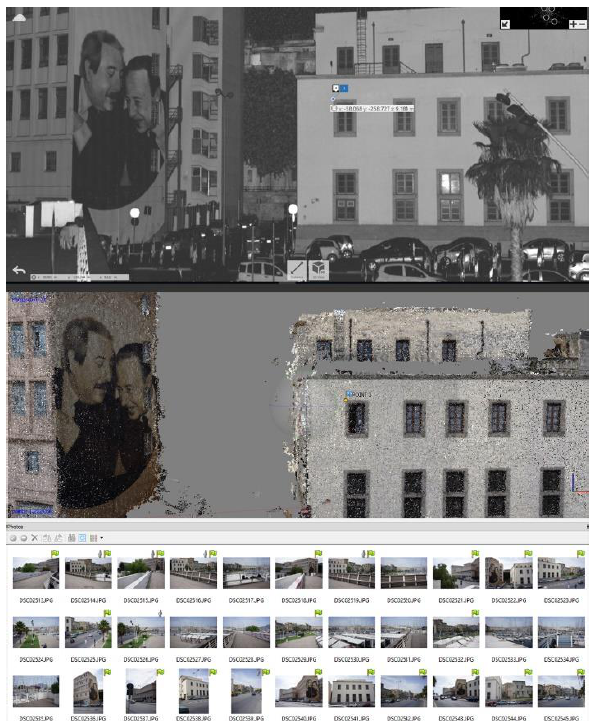
Figure 10: Marker coordinates from Recap and Marker creation in Photoscan.